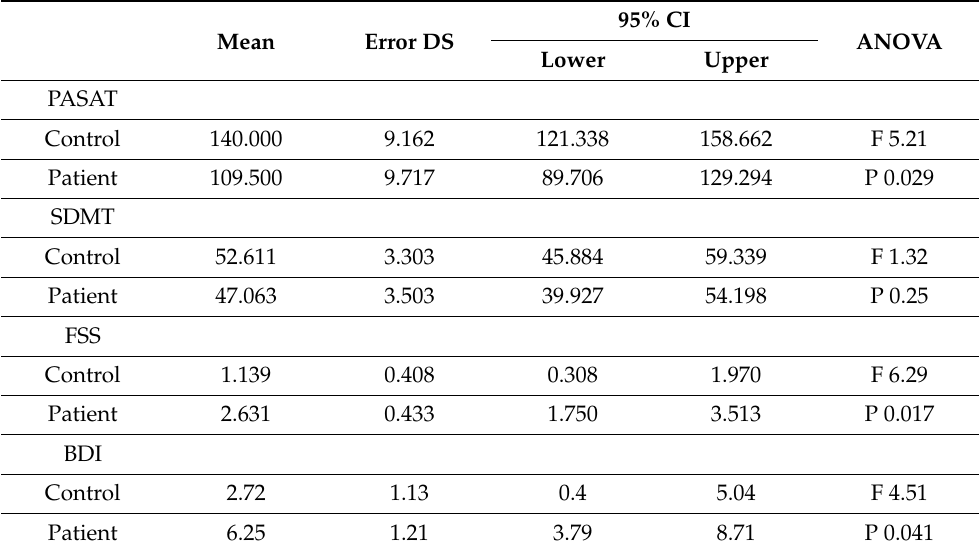
Table 2. Mean values and statistical analysis of cognitive tests, fatigue severity scale inventory (FSS), and Beck Depression Inventory (BDI) between 16 pwMS and 19 HCs.